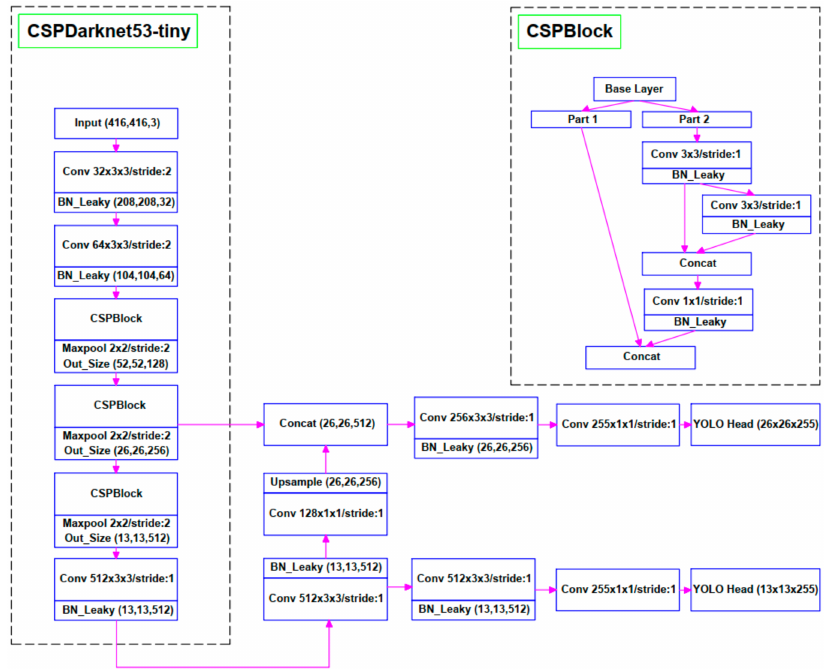
Figure 2. Network architecture of YOLOv4-tiny.